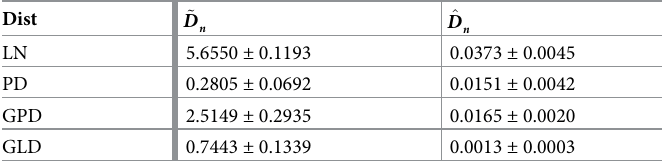
In Fig 6, we show the contour plot of the fitted joint distribution by excluding the data in the first class of firm size. We keep all age groups and estimate the marginal distribution of firm age with EWD. Without the first class, GLD fits the firm size data better than PD and GPD in terms of BIC and ^ D , but PD fits the upper tail the best (with the smallest ~ D n the two estimates of the joint distribution are similar. The MLEs of C are 43.19 and 53.12 for